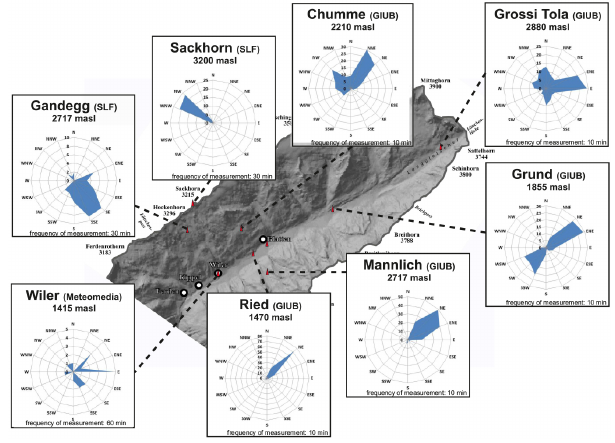
Figure 5. Frequency of 2m wind directions from station measure- ments on 10 October in the Lötschen Valley. The radial component of each direction (in blue) indicates the number of measurements when the wind was blowing from that respective direction in 24h. Note that the total number of measurements varies since wind is measured every 60, 30 or 10min depending on the station. Particu- larly remarkable is that the neighboring stations Sackhorn and Gan- degg recorded opposite wind directions. This can be explained by the presence of cavity circulation (schematized in Fig. 6).